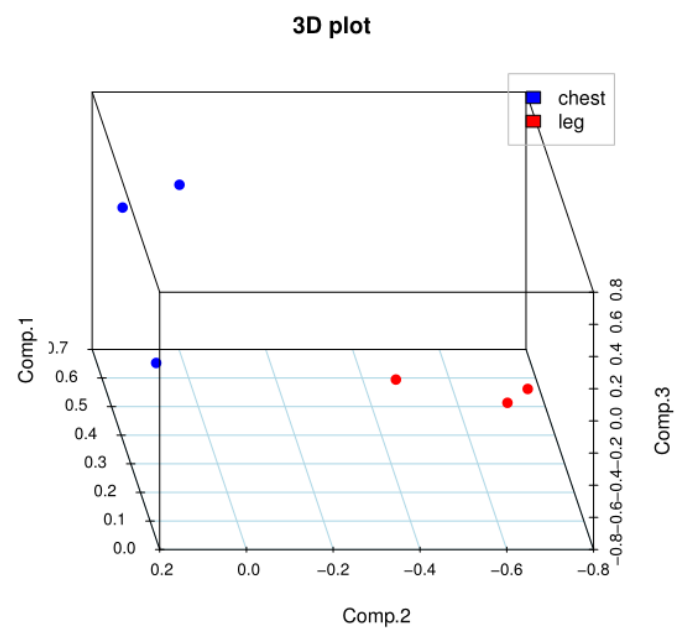
Figure 2. Principal component analysis of chest and leg.